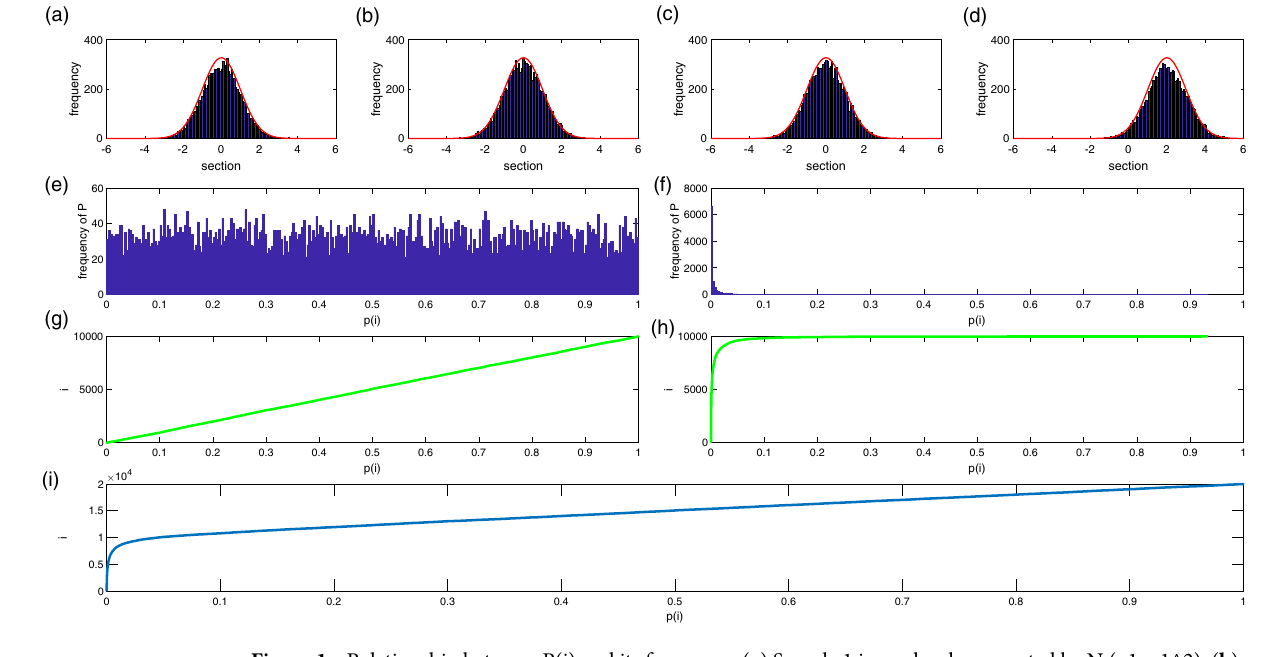
Figure 1. Relationship between P(i) and its frequency. ( a ) Sample 1 is randomly generated by N (μ1, σ1^2). ( b ) Sample 2 is randomly generated by N (μ2, σ2 ^ 2), µ 1 = µ 2 , and σ 1 = σ 2 . ( c ) Sample 3 is randomly generated by N (μ3, σ3 ^ 2). ( d ) Sample 4 is randomly generated by N (μ4, σ4 ^ 2), µ 3 = µ 4 , and σ 3 = σ 4 . ( e ) Frequency distribution of P(i) in hypothesis testing using samples 1 and 2. At this time, H0 is true, and the calculated P value is evenly distributed between 0 and 1. ( f ) Frequency distribution of P (i) hypothesis testing of sample 3 and 4. H0 is false, and most of the calculated P value is distributed between 0 and 0.05. ( g ) P (i) vs i when samples 1 and 2 are used for hypothesis testing. The P-value accumulation curve is close to a straight line, which passes through two points (0, 0) and (0, m). ( h ) P(i) vs i when samples 3 and 4 are used for hypothesis testing. When the P value is small, the cumulative P value quickly reaches m. ( i ) P (i) vs i sample 1 and 2, sample 3 and 4 are paired for hypothesis testing, respectively. When the P value is very small, the accumulation of the P value rises quickly. When the P value is greater than some value (for example, 0.05), the accumulation curve of the P value approaches a straight line. The picture was drawn using R programming language (https:// www.r- proje ct. org/,